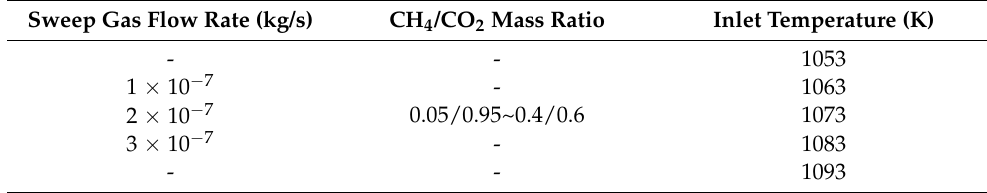
Table 2. Variation range of boundary condition parameters in parametric